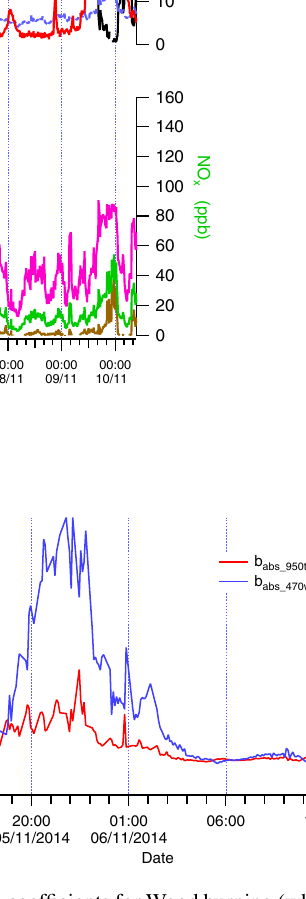
Figure 3. Absorption coefficients for Wood burning (wb) and traffic